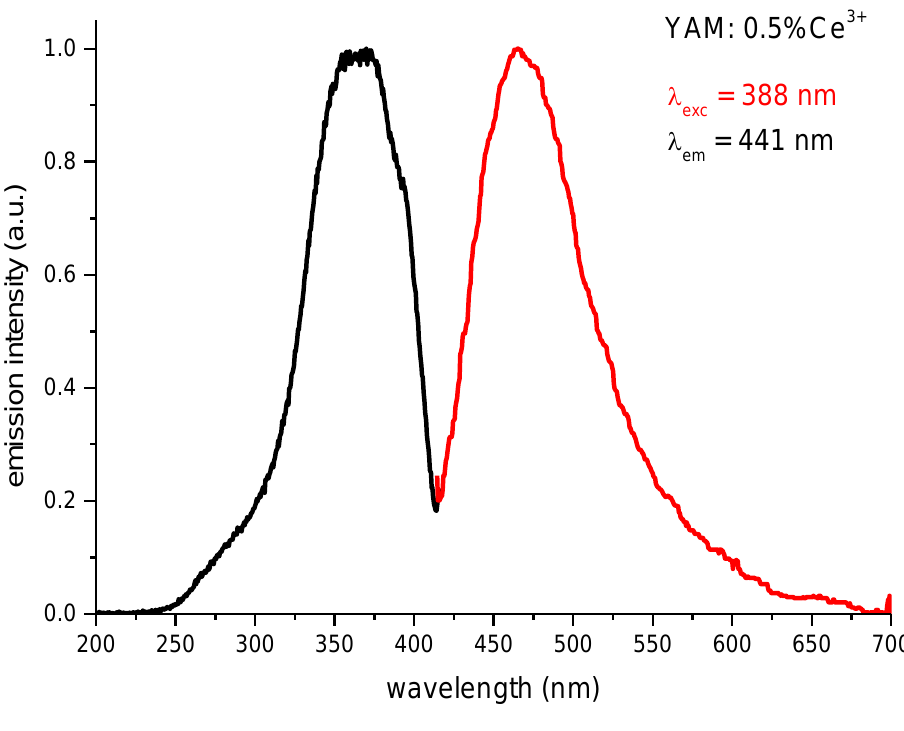
Figure 3. Excitation and emission spectra of Ce 3+ -only activated YAM samples.